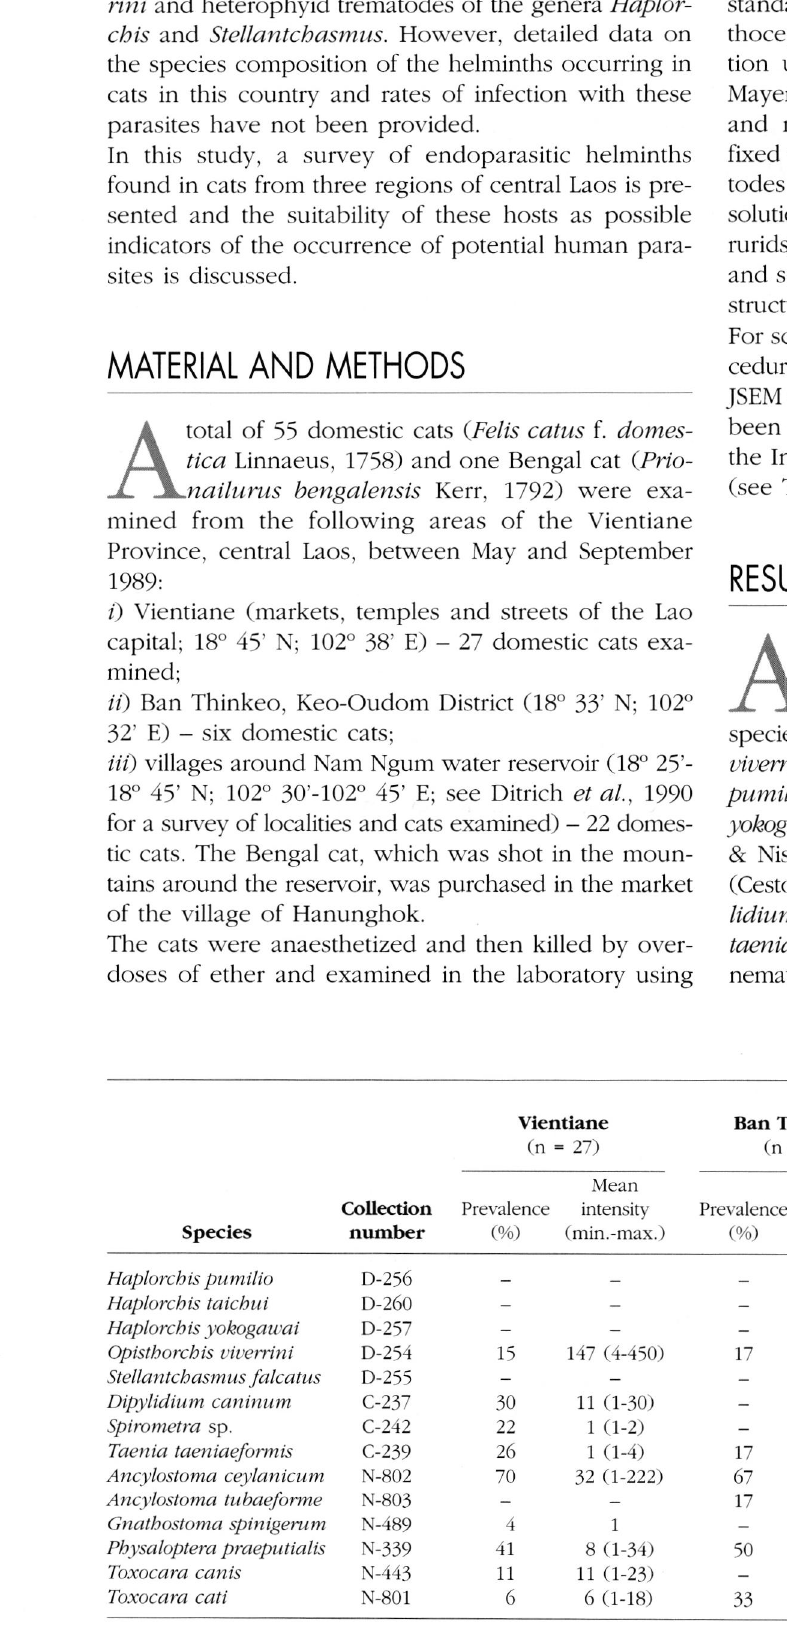
Table I. - Helminths found in domestic cats in Vientiane Province, central Laos.